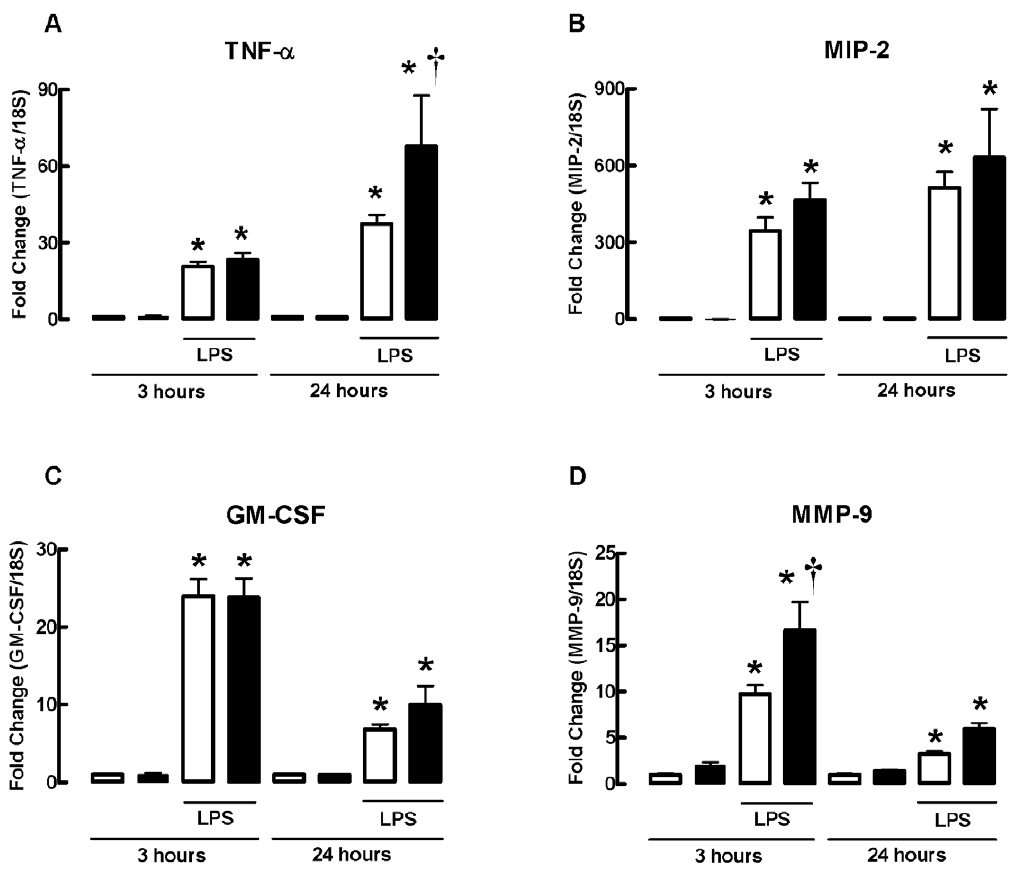
Figure 5. Effect of LPS on whole lung TNF- a , MIP-2, GM-CSF and MMP-9 mRNA expression in WT and gpx-1 2 / 2 mice. mRNA expression for all genes was measured simultaneously under identical conditions using quantitative real-time PCR. Responses are shown as fold change relative to 18S from 6 individual mice. Clear bars represent WT mice and black bars represent gpx-1 2 / 2 mice. * P , 0.001 vs PBS (ANOVA and Bonferroni’s post hoc test), { P , 0.05 vs WT (ANOVA followed by Bonferroni’s post hoc test).